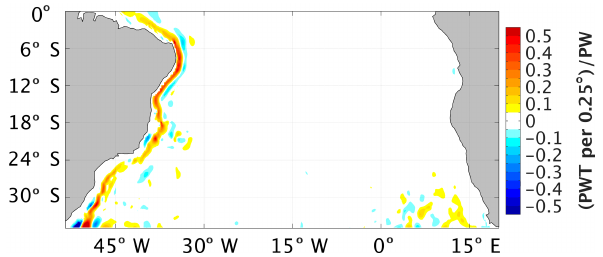
Figure 9. The linear regression coefficient between the inter- product p _OTTs and their MHTs for each latitude. Units are in PWT per 0.25 ◦ per 1PW across each